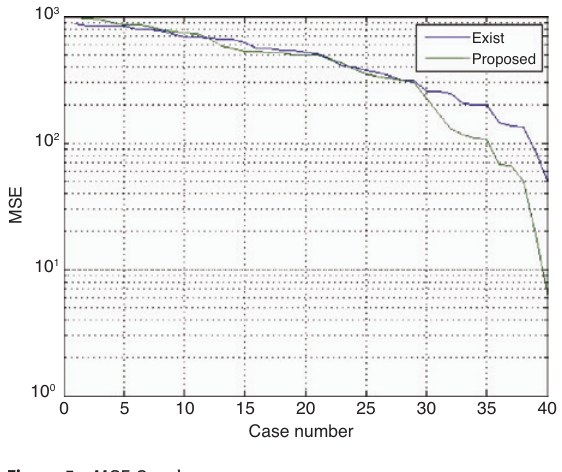
Figure 5: MSE Graph.